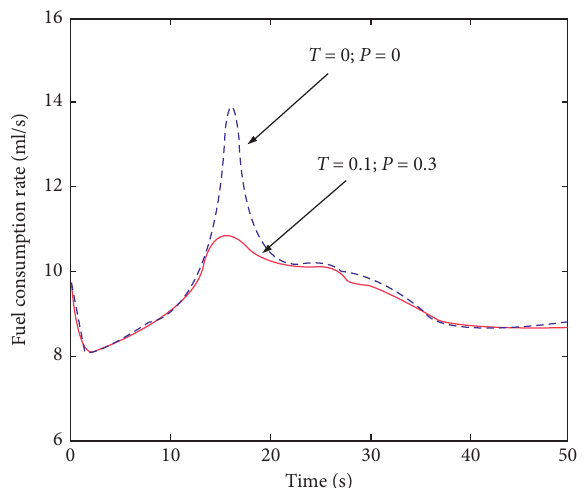
Figure 14: Total fuel consumption of each vehicle during departure and arrival process simulated by the AFVD model ( T � 0, p � 0), the AAFVD model ( T � 0.1, p � 0 . 3).